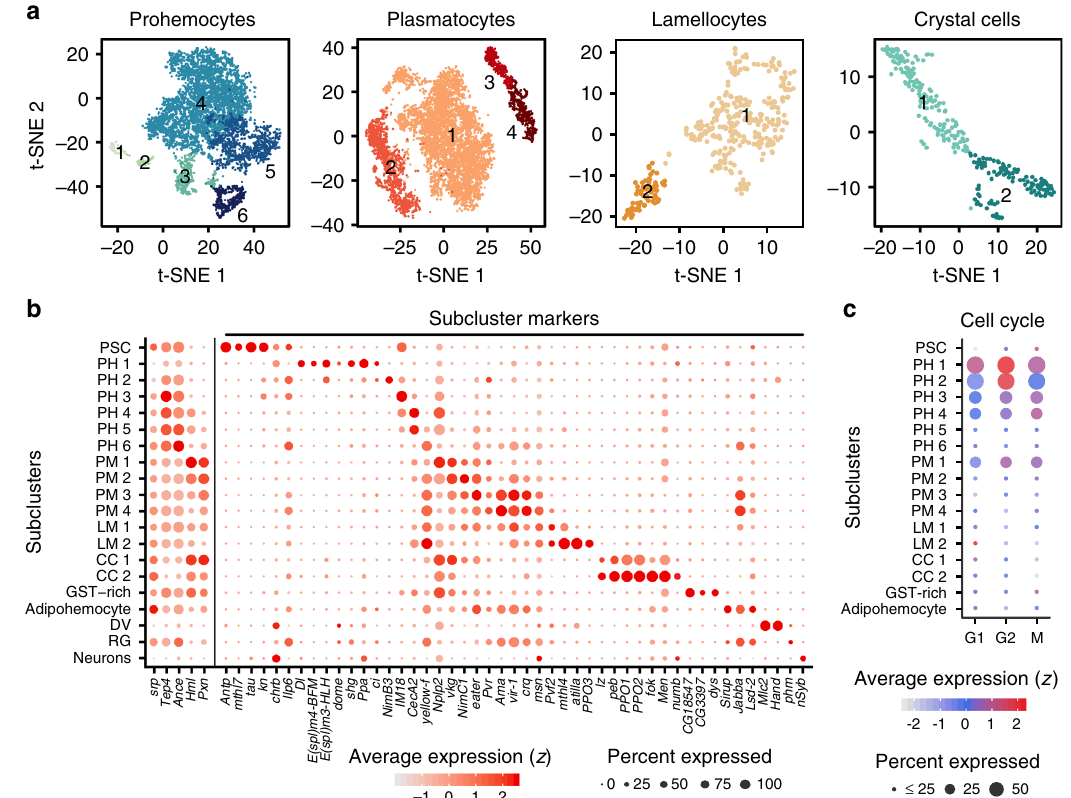
Fig. 2 Subclustering analysis of hemocytes in the lymph gland. a Subclusters of hemocytes — prohemocytes, plasmatocytes, lamellocyte, and crystal cells — are projected onto two-dimensional t -SNE plots. The numbers in the plots represent the subcluster number. b Dot plot presentation of signi fi cant gene sets in the 17 subclusters using Wilcoxon Rank-Sum test. 5 representative markers, srp , Tep4 , Ance , Hml , and Pxn are indicated to the left column. Signature genes identi fi ed in this study are marked with subcluster markers. Dot color shows levels of average expression, and dot size represents the percentage of cells expressing the corresponding marker genes in each subcluster. Non-hematopoietic cell types are indicated (DV, dorsal vessel; RG, ring gland; Neurons). Cell count for each subcluster is listed in Supplementary Table 4. c Expressions of cell-cycle regulating genes in 17 subclusters. Dot color indicates average expression levels and dot size displays the percentage of cells with cell cycle controlling genes ( Cdk1 , CycD , and CycE for G1; stg , CycA , and CycB for G2; polo , aurB , and Det for M) in each